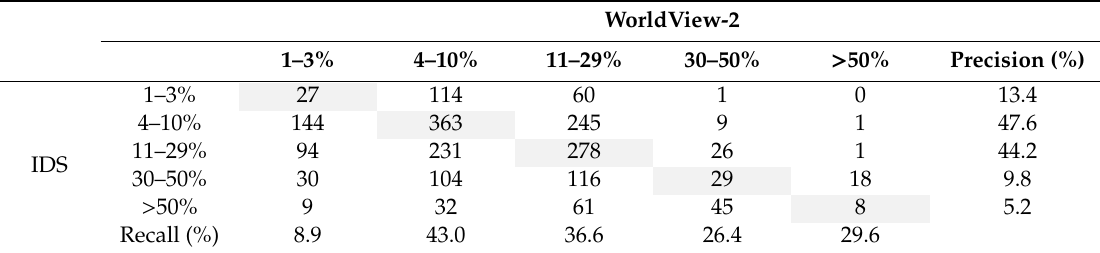
Table A2. Comparison of percent tree mortality area derived from 2018 WorldView-2 and IDS polygons (2014–2018 cumulative). Values in matrices are counts of IDS polygons. IDS trees per acre